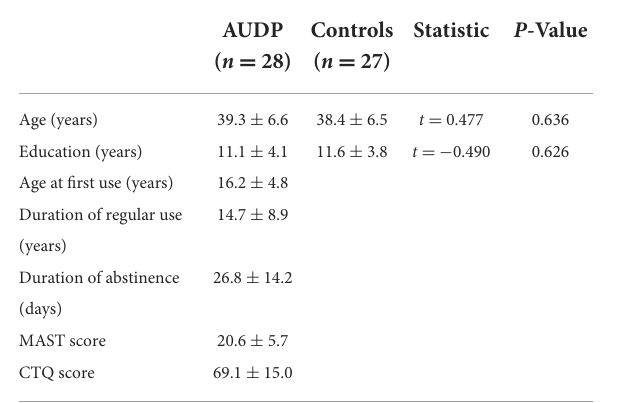
TABLE 1 Demographic and clinical characteristics of AUDP and healthy control subjects.